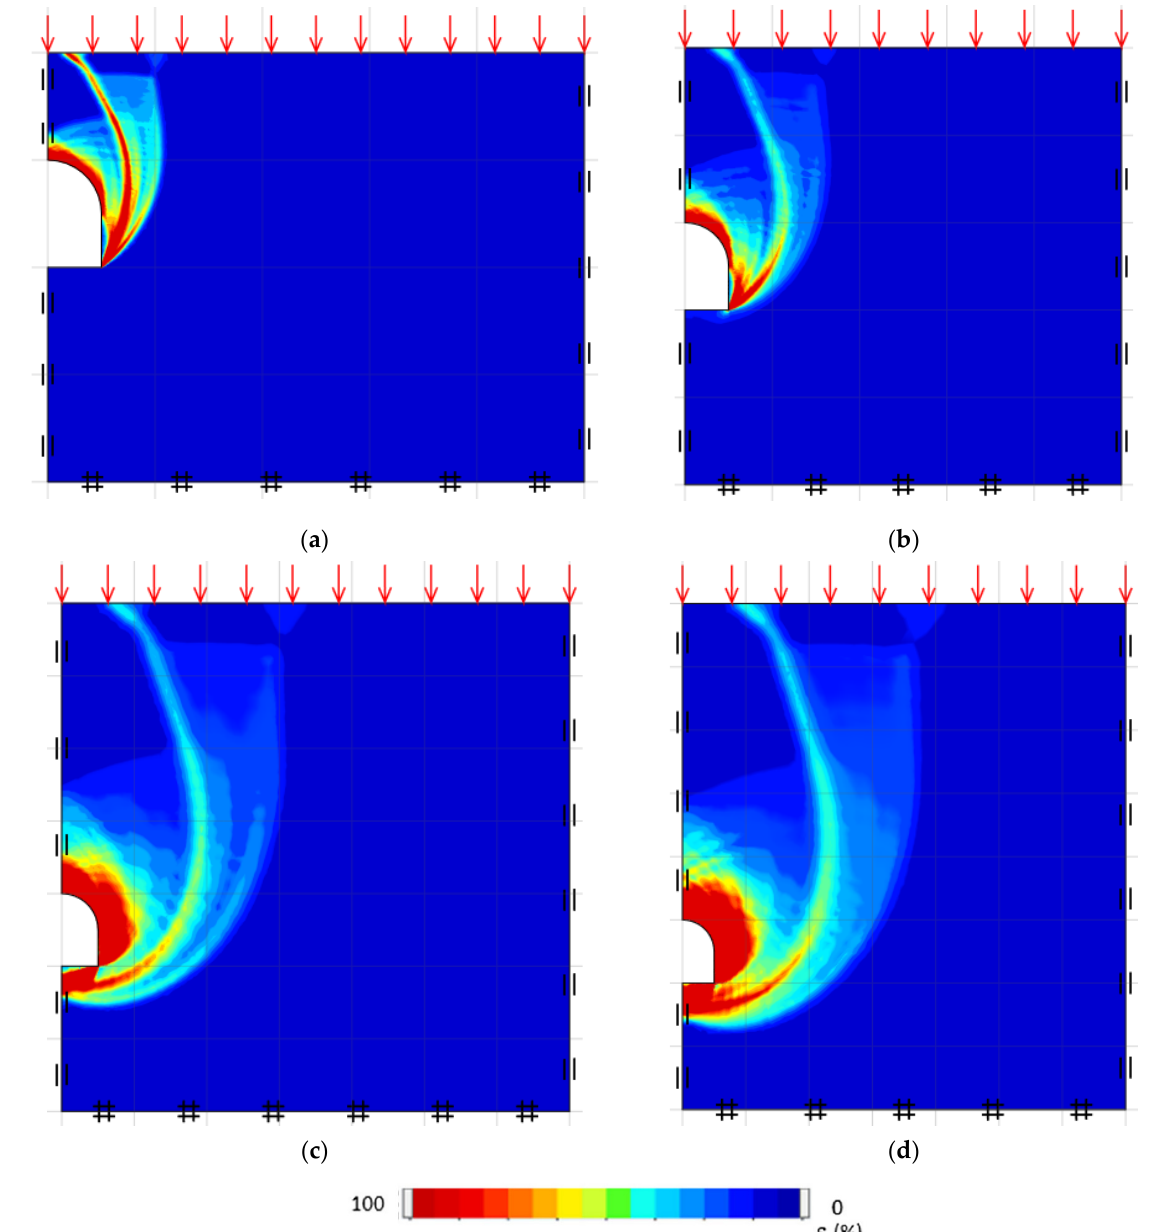
Figure 14. Shear dissipations of horseshoe tunnel with B / D = 1 for the cases of C / D : ( a ) 1, ( b ) 2, ( c ) 4 and ( d ) 5 ( σ ci / γ D = 1000, GSI = 80 and m i = 20).